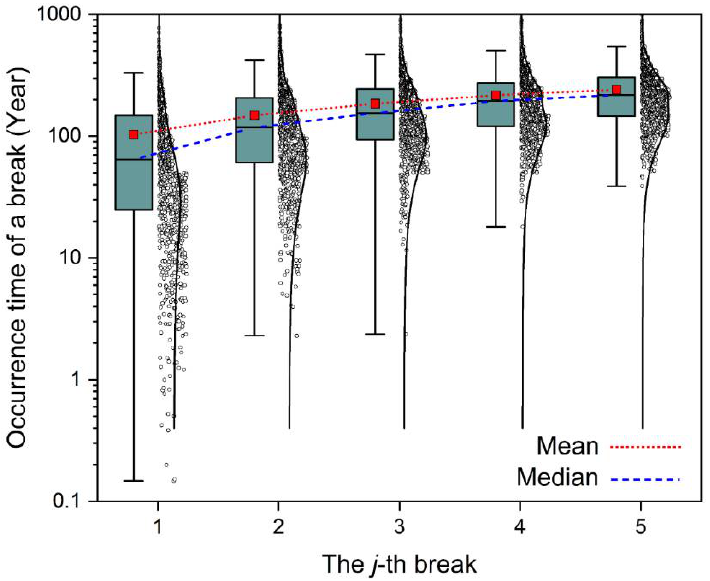
Figure 10. Predictions of occurrence times for the first five breaks for the example water main. Table 5. Mean, median, and COV of predictions of the first five breaks for the example water main.